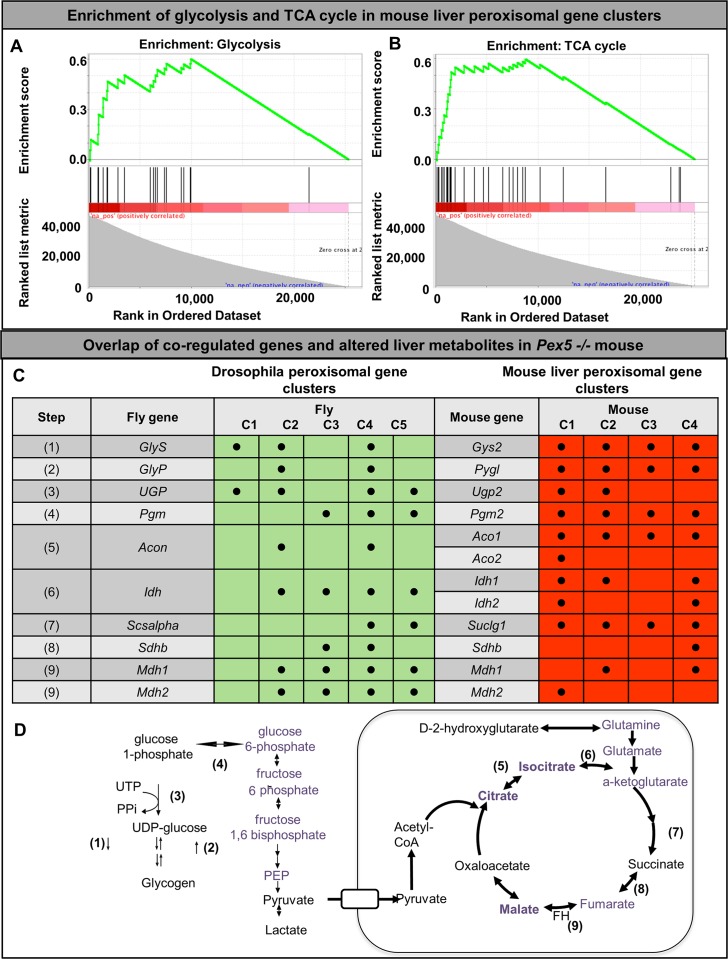
Gene network and metabolomic enrichment of carbohydrate metabolism in peroxisomal gene networks.(A) Gene set enrichment analysis (GSEA) of peroxisomal genes in mouse liver networks showing a strong enrichment for glycolysis. The y-axis shows the enrichment score or Kolmogorov-Smirnov-like statistic representing to what degree genes are over-represented in the ranked list of genes across the murine genome. (B) Gene set enrichment analysis (GSEA) of peroxisomal genes in mouse liver networks showing a strong enrichment for TCA cycle. The y-axis shows the enrichment score or Kolmogorov-Smirnov-like statistic representing to what degree genes are over-represented in the ranked list of genes across the murine genome. (C) Overlap of the Drosophila and mouse liver peroxisomal gene clusters. Several genes in carbohydrate metabolism were represented in the top 1000 genes within the Drosophila peroxisomal gene cluster and the top 1000 genes within the Drosophila murine liver clusters. These genes represent 9 steps in carbohydrate metabolism including glycogen metabolism, and several steps in the TCA cycle. (D) Overlap of the co-regulated steps in carbohydrate metabolism with the altered metabolites seen in Pex5 mouse liver. In purple are altered metabolites in the liver specific Pex5 mouse, and in bold purple are those altered in both the liver specific Pex5 mouse as well as the fetal Pex5 knockout mouse.